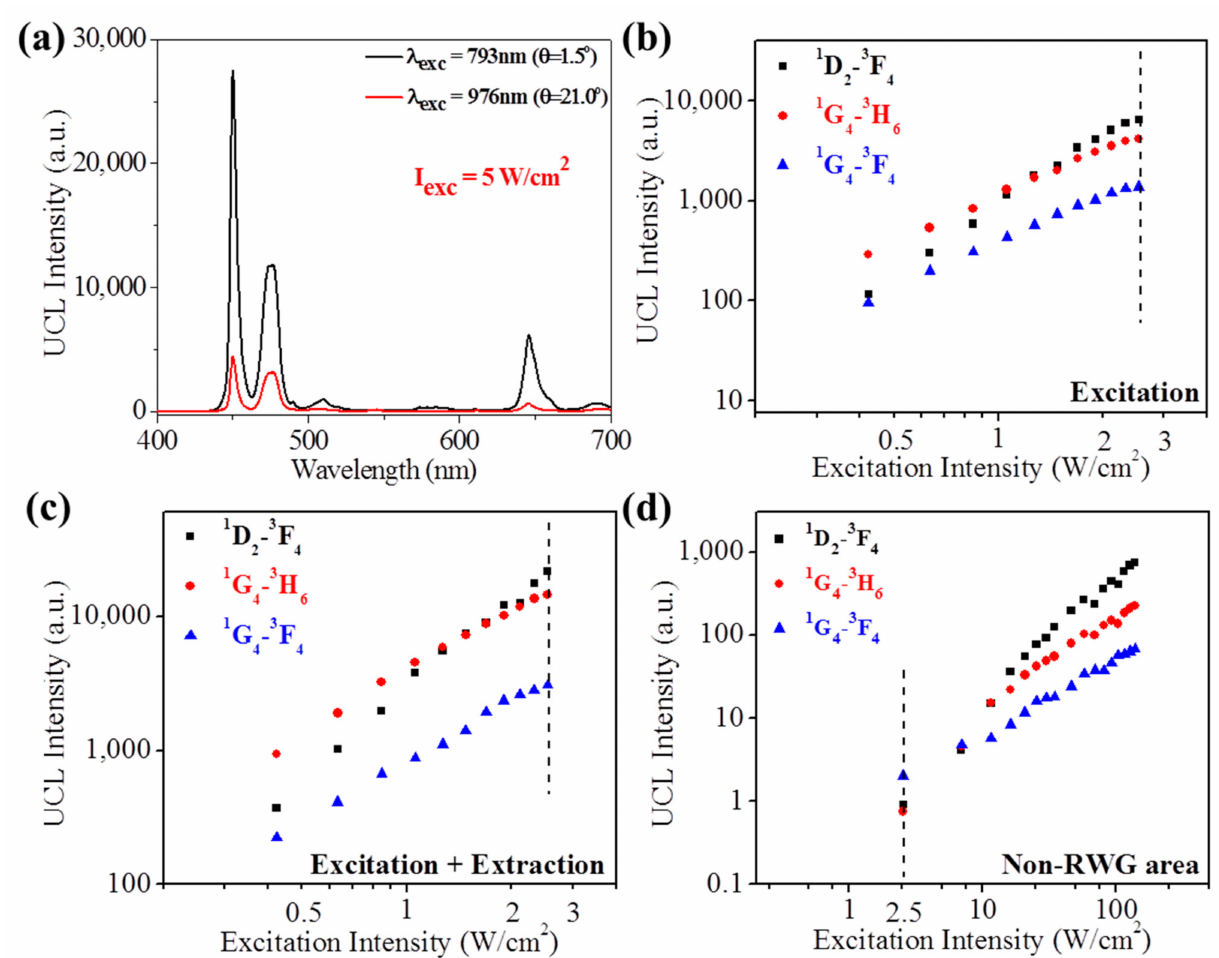
Figure 5. ( a ) UCL spectra of the CSS UCNPs deposited on the top surface of the low − n RWG structures under excitation resonances with two different incident wavelengths at λ = 793 nm ( θ = 1.5 ◦ ) and λ = 976 nm ( θ = 21.0 ◦ ). Excitation intensity dependences of three main UCL peak intensities obtained from the CSS UCNPs deposited on the low − n RWG sample under ( b ) excitation resonance, ( c ) excitation resonance + extraction resonance, and ( d ) the UCL obtained from a non − RWG